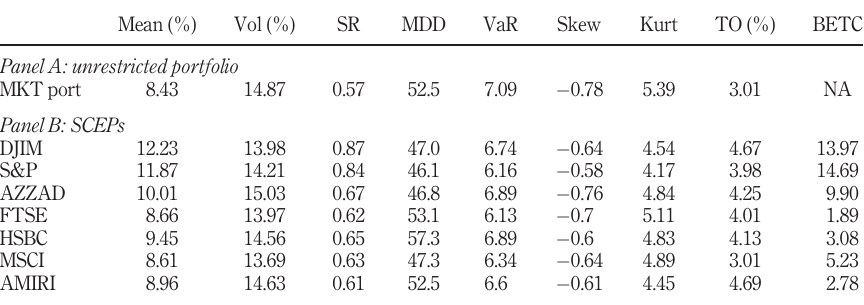
Table 3. Effect of Shar ī ʿ